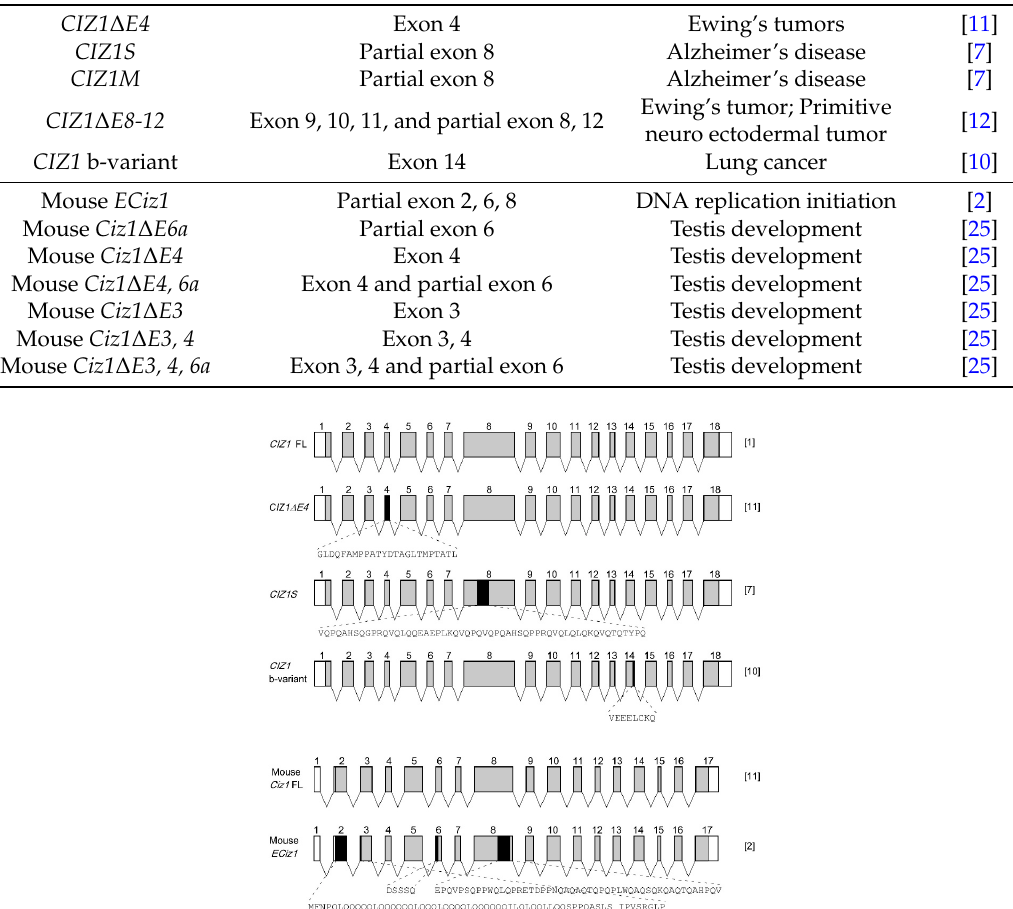
Table 1. Alternative splicing patterns of CIZ1 mRNA.